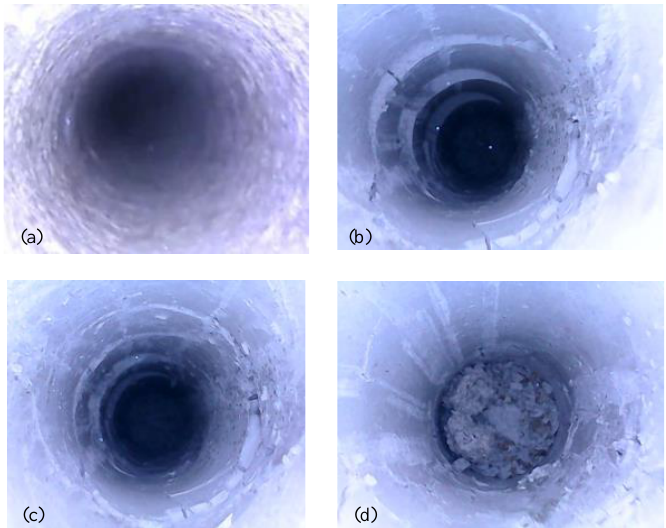
Figure 10. Borehole deformation in the physical model. ( a ) Initial stage; ( b ) Stepped dislocation; ( c ) Dislocation recovery; ( d ) Borehole blocking. ( c ) Dislocation recovery; ( d ) Borehole